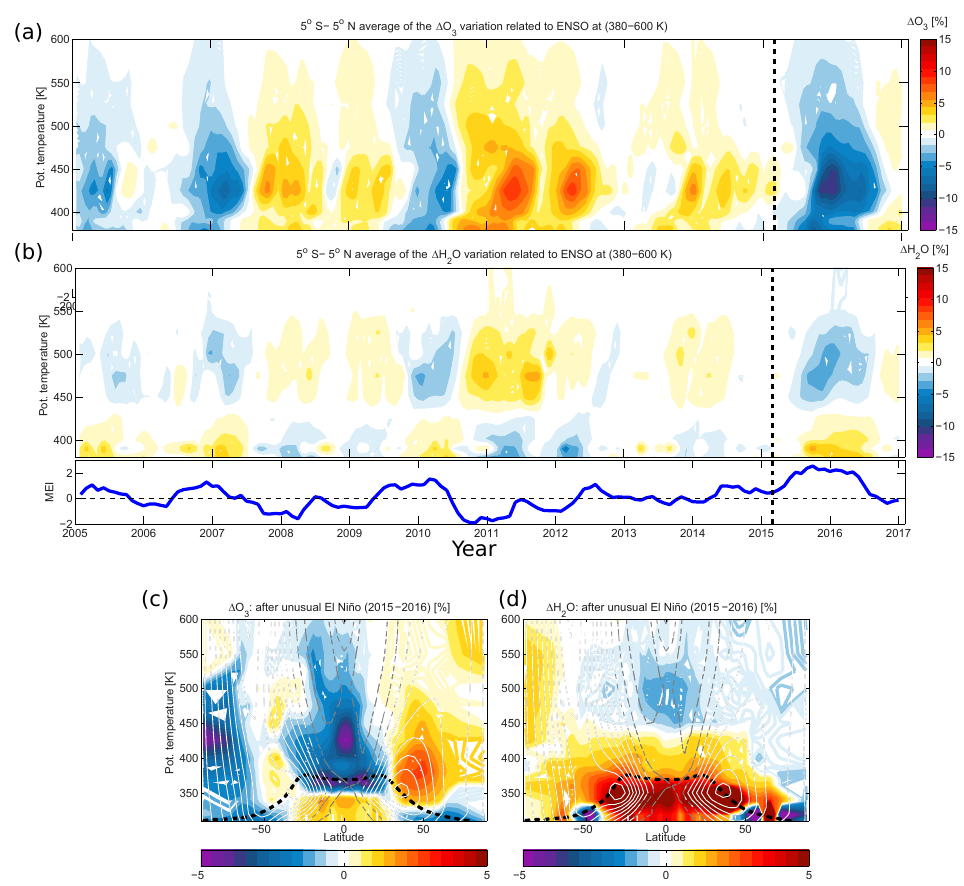
Figure 2. ENSO impact on the stratospheric O 3 (a) and H 2 O (b) from MLS satellite observations for the 2005–2016 period in percent change relative to monthly mean mixing ratio as a function of time and potential temperature. The ENSO impact on the stratospheric trace gases is derived from the multiple regression fit as the difference between the residual ( (cid:15) in Eq. 1) without and with explicit inclusion of the ENSO signal. Vertical black dashed line indicates the warm ENSO onset (February 2015). The lower panel below indicates the MEI index in blue. Panels (c–d) show the zonal distribution of the ENSO impact on stratospheric O 3 (c) and H 2 O (d) averaged from January 2015 to December 2016 in percent change relative to monthly mean mixing ratios. The black dashed horizontal line indicates the tropopause from ERA-Interim. Zonal mean zonal wind component, u (ms − 1 ), averaged over the 2015–2016 period, from ERA-Interim is overlaid as solid white (westerly) and dashed gray (easterly)